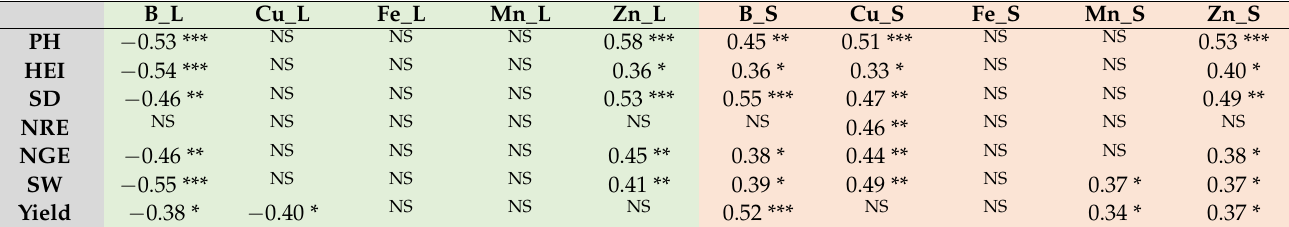
Table 4. Correlation matrix according to Pearson’s correlations